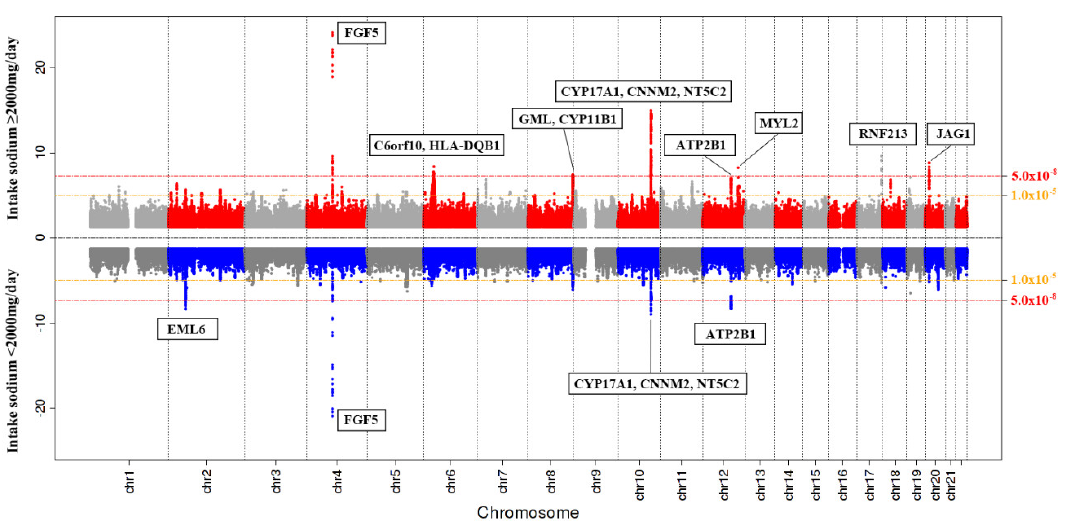
Figure 2. A Miami plot shows p -values for the SNP associations with hypertension in participants whose sodium intake was either <2 g/day or ≥2 g/day.